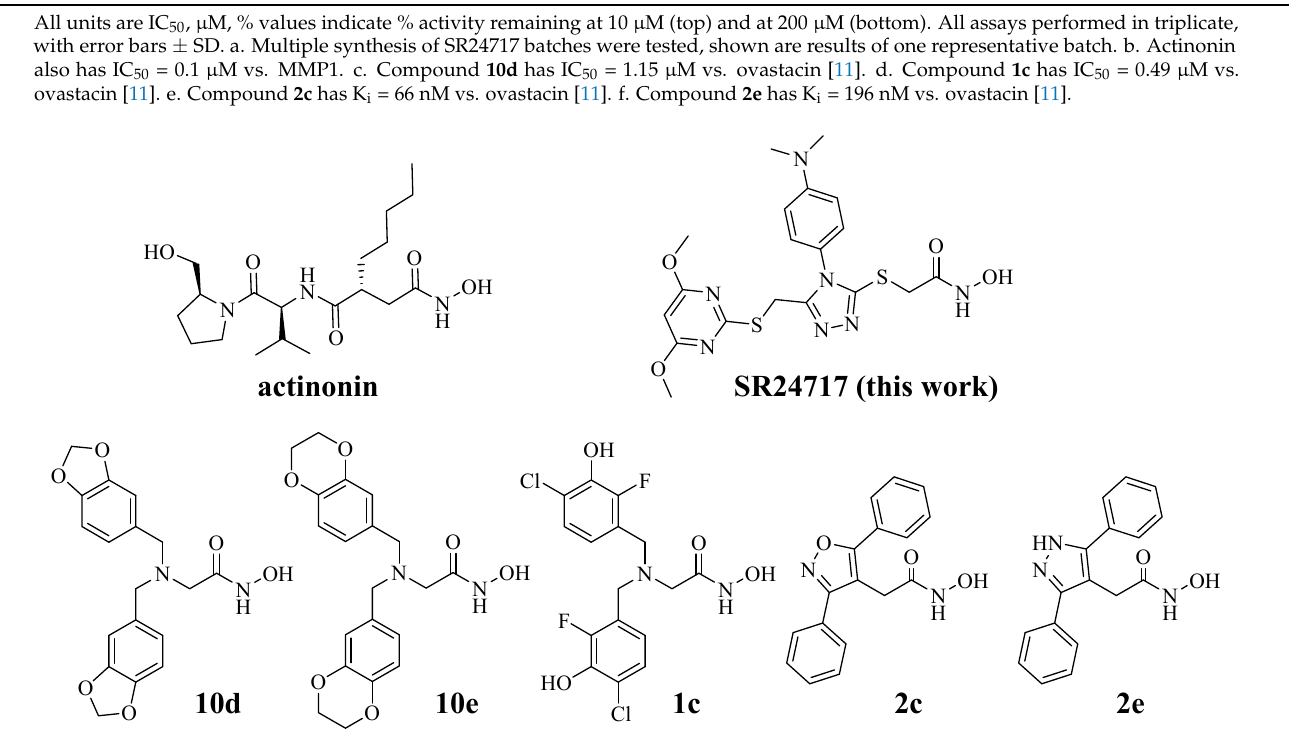
Figure 7. Structures of literature meprin inhibitors: actinonin, SR24717, 10d [8]; 10e [8], 1c [11], 2c [11], 2e [11].